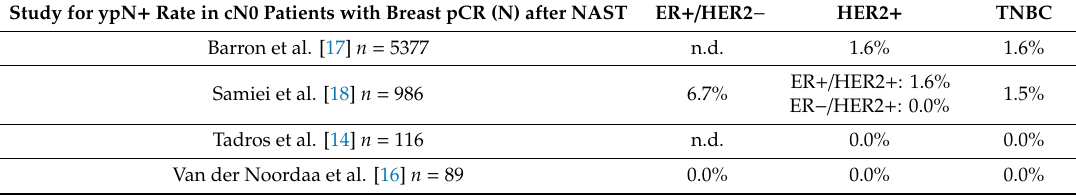
Table 1. List of trials with axillary interventions after neoadjuvant systemic therapy (NAST) reporting outcomes regarding ypN + rate with respect to initially clinical nodal status and breast